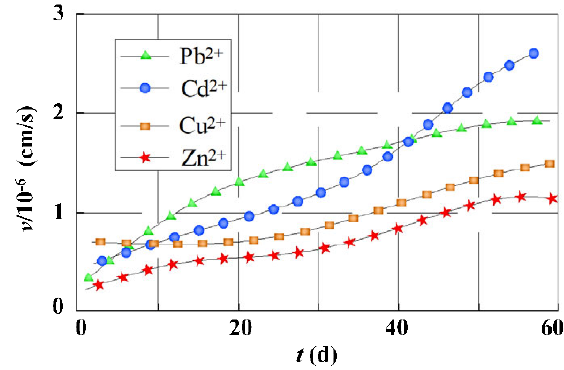
Fig. 8. The correlation curve of extension performance of heavy metal